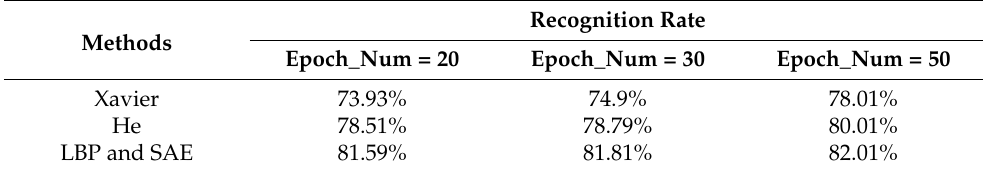
Table 3. The comparison of the recognition rate of three initialization